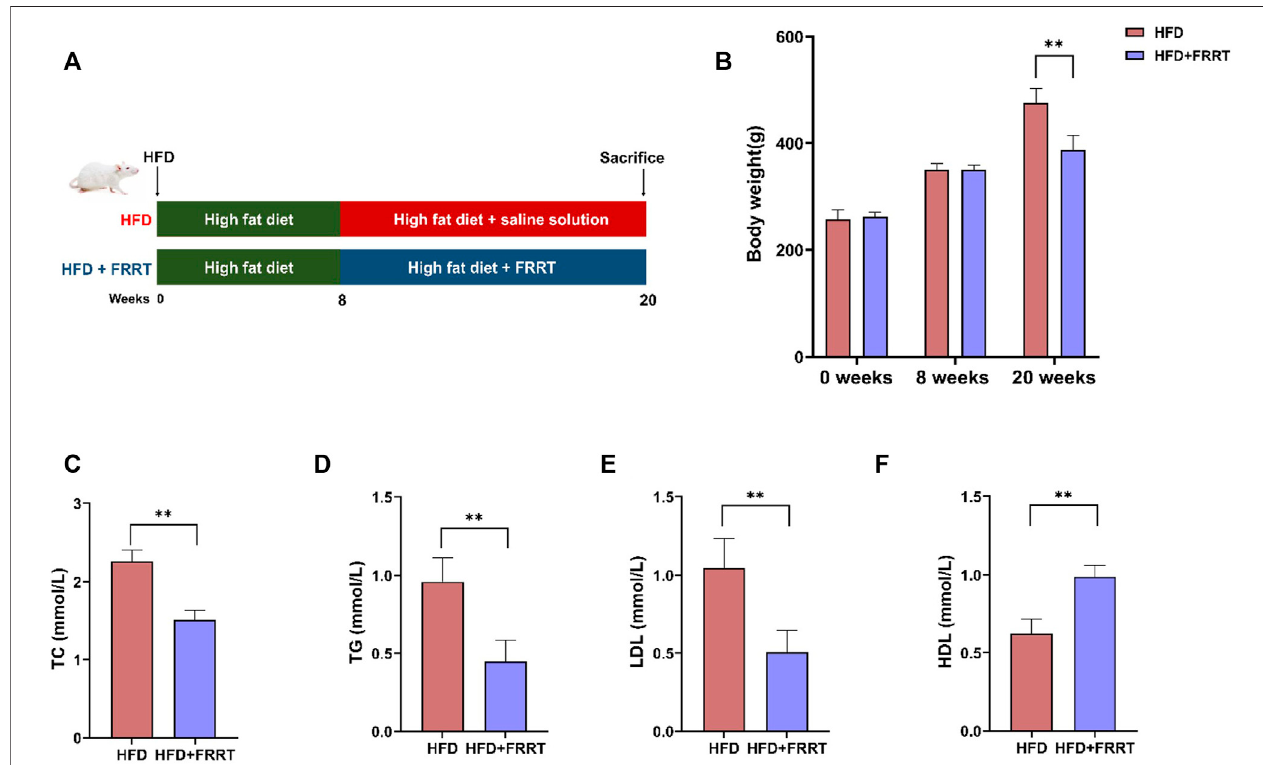
FIGURE1| FRRTimprovesdyslipidemiainHFD-inducedhyperlipidemicRats. (A) SchematicdiagramofFRRTtreatment. (B) Rats ’ bodyweightatweeks0,8,and 20. Serum TC (C) , TG (D) , LDL-c (E) , and HDL-c (F) levels were measured using commercial kits. Data are presented as mean ± SEM ( n = 6). * p < 0.05, ** p < 0.01 compared with HFD